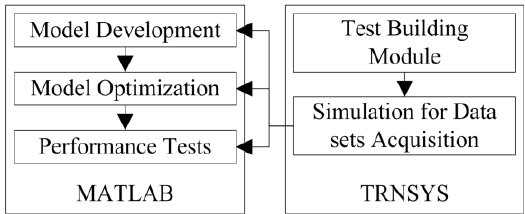
Figure 2. Flow of the artificial neural network (ANN) model development.